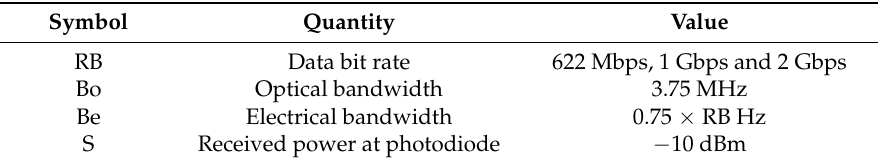
Table 2. Typical parameters used in numerical analysis.